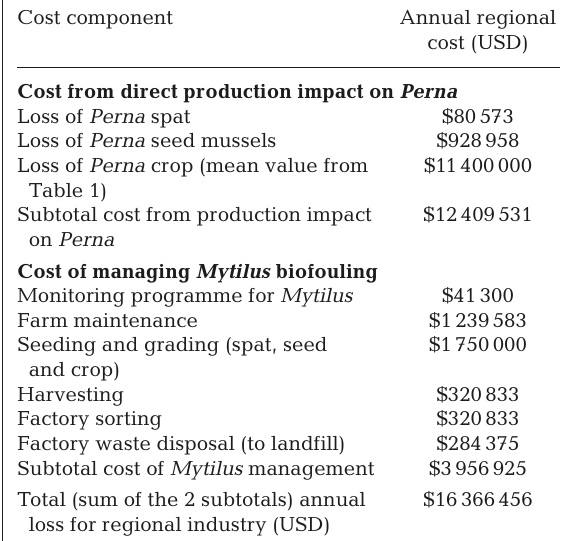
Table 2. Estimated annual regional economic loss due to Mytilus galloprovincialis across all stages of the industry production chain for Perna canaliculus . All monetary values are expressed in USD, calculated from raw data in NZD using an exchange rate of NZD $1.00 = USD $0.70. See ‘Materials and methods’ for